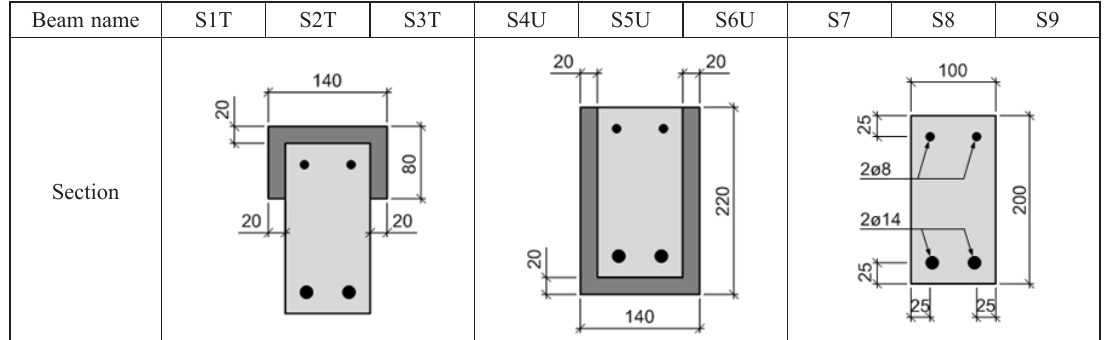
Table 1. Characteristics of the